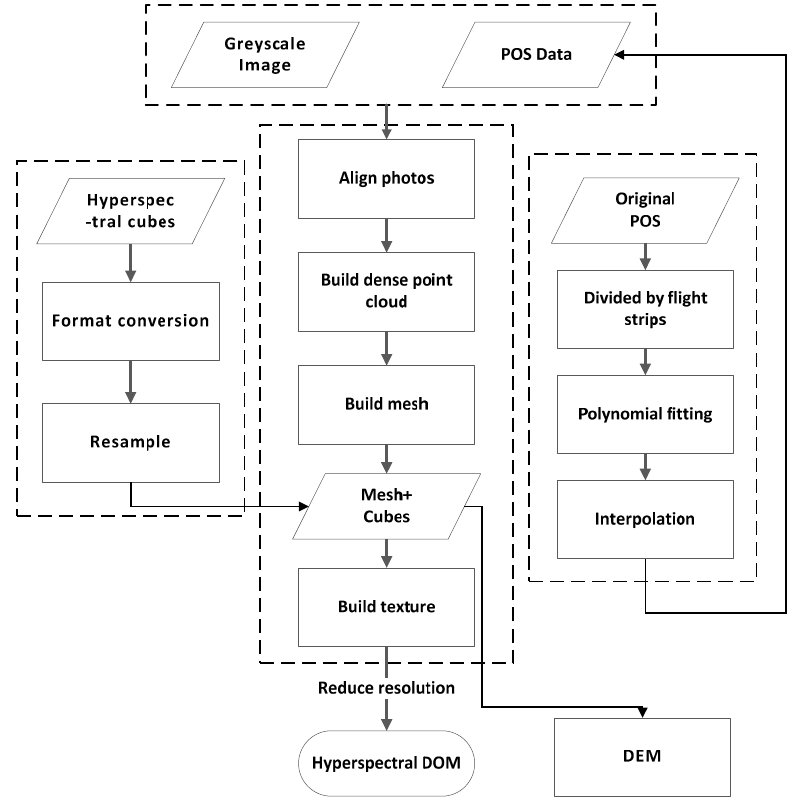
Figure 3. Flowchart for DOM and DEM generation.